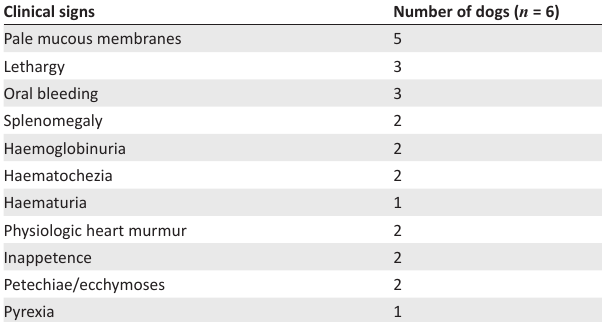
TABLE 1: Clinical signs in six dogs with